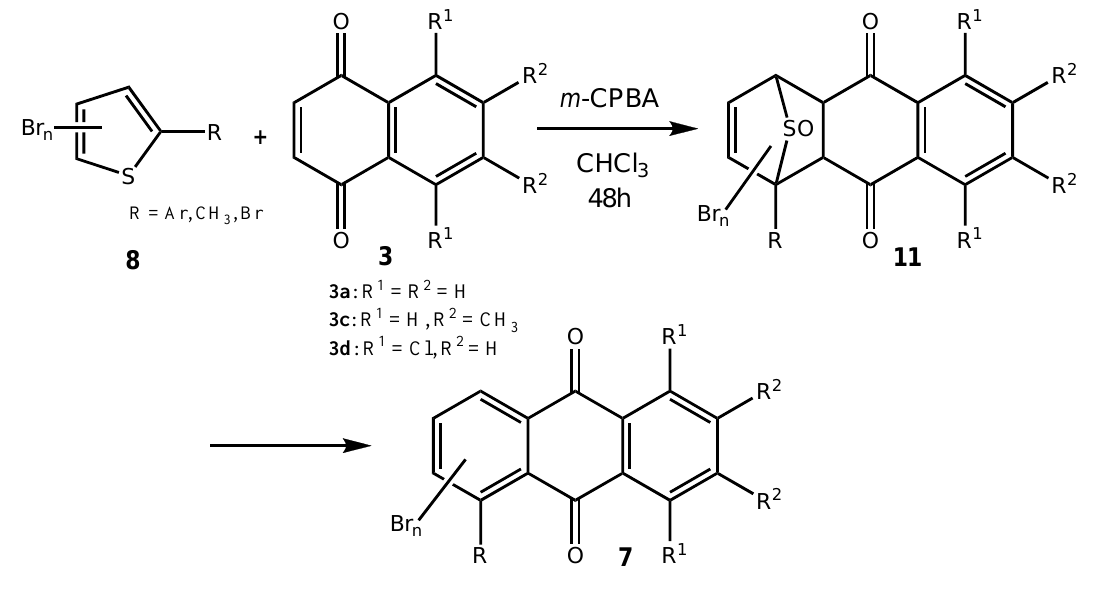
Table 1. Preparation of bromoanthraquinones by oxidative cycloaddition of thiophenes to